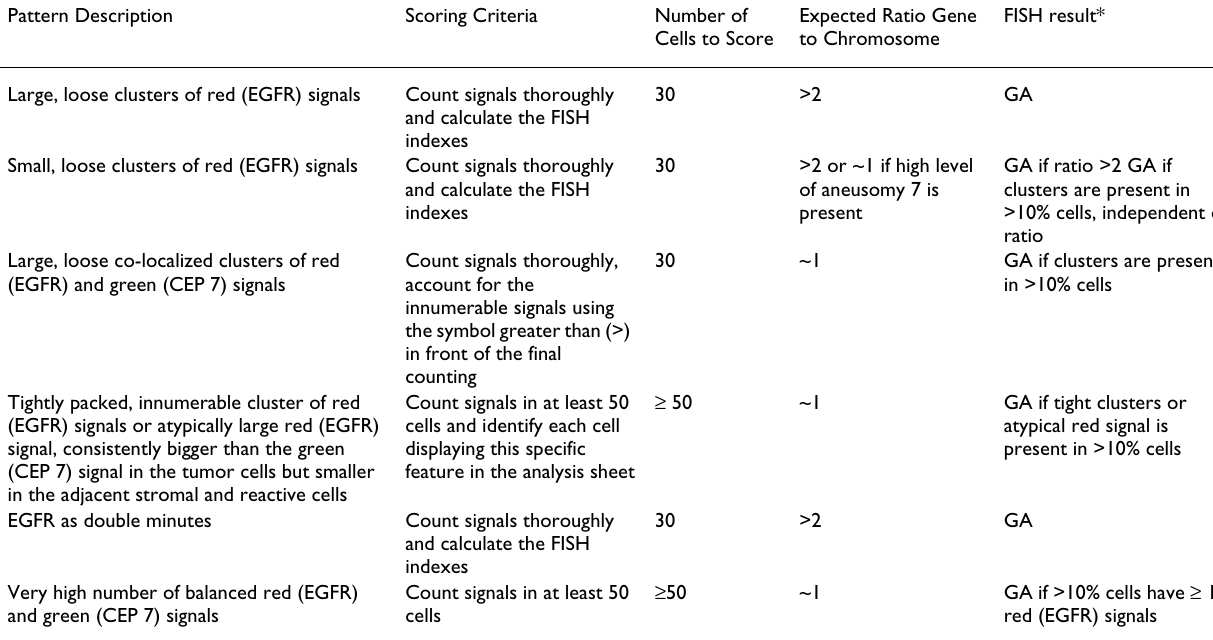
Table 3: UCCC scoring and interpretation of different types of EGFR gene amplification in NSCLC specimens. Pattern